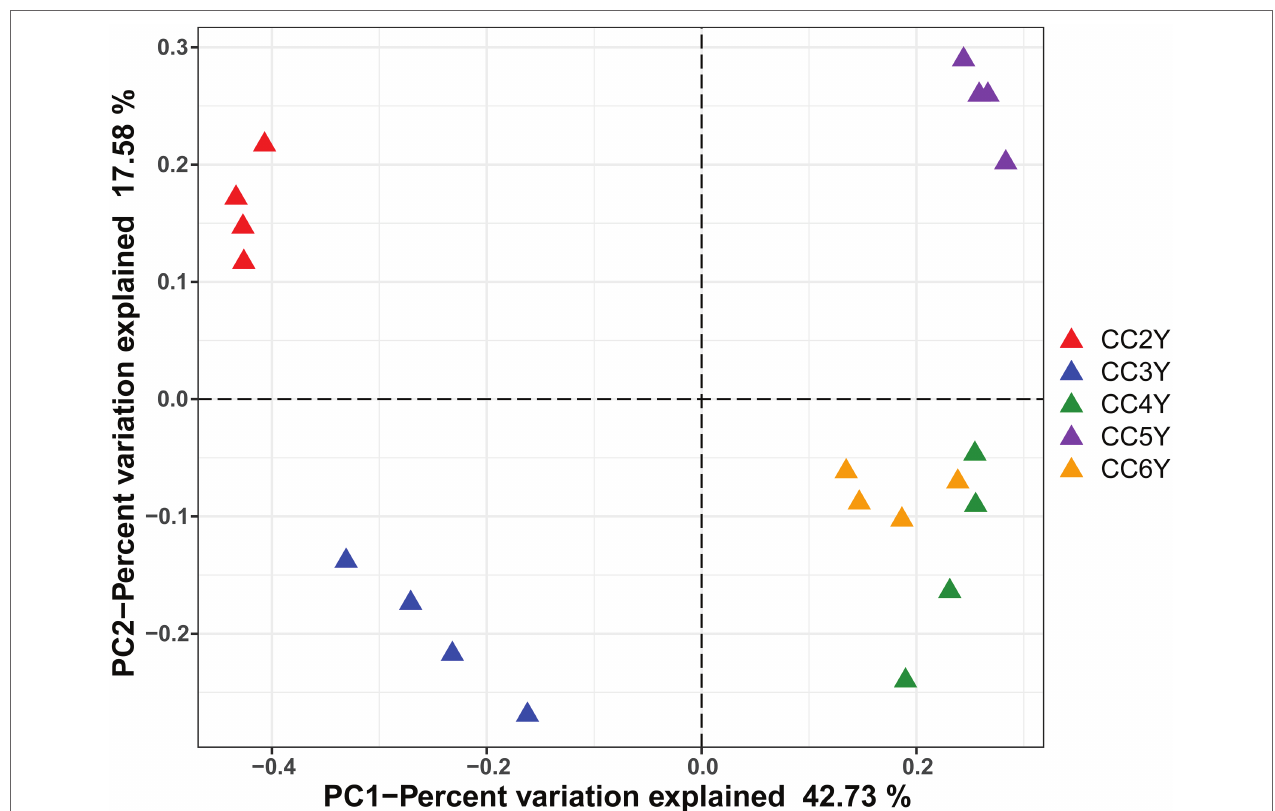
FIGURE 2 | PCoA of fungal communities in the rhizosphere soil samples based on Bray–Curtis distances. CC2Y, CC3Y, CC4Y, CC5Y, and CC6Y represent continuous cropping for 2, 3, 4, 5, and 6 years, respectively. The percent variation of the plotted principal component is indicated on the